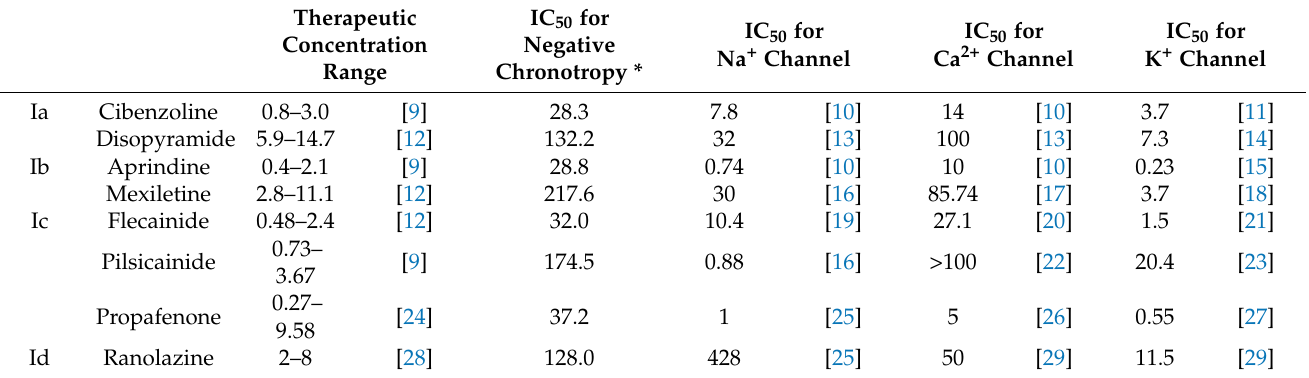
Table 1. Therapeutic concentration range and IC 50 values ( µ M) of Class I antiarrhythmic